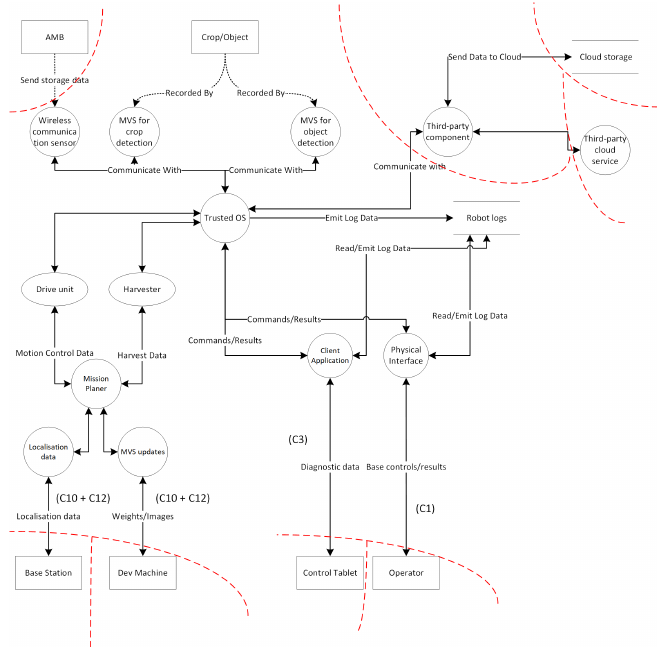
Figure 3. Data Flow Diagram of the IHR. Table 2. Critical Assets of IHR from a Security